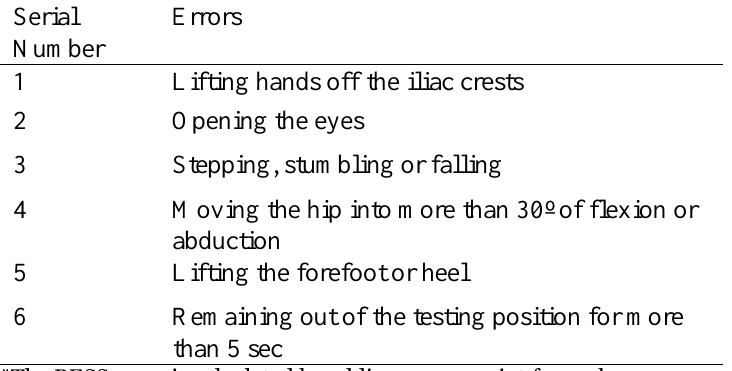
Table 1. List of items in Balance Error Scoring System*